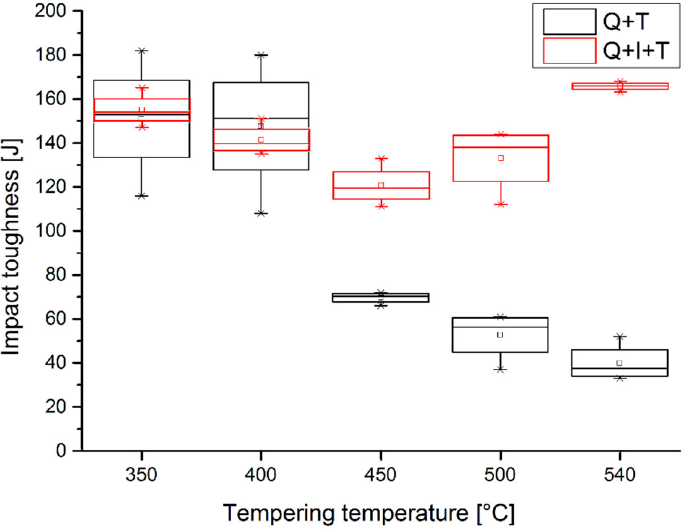
Figure 10. Charpy impact toughness for Q + T and Q + I + T samples at different tempering tem- peratures.